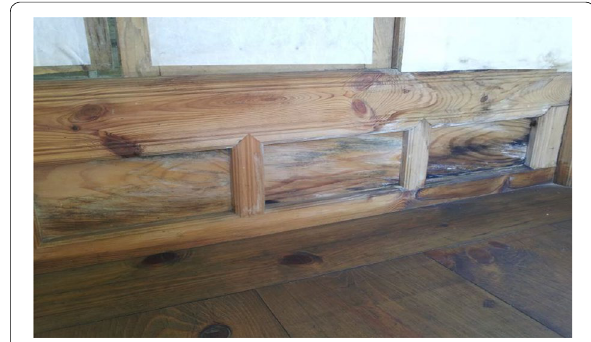
Fig. 1 Severe fungal discoloration of unfinished interior wood members